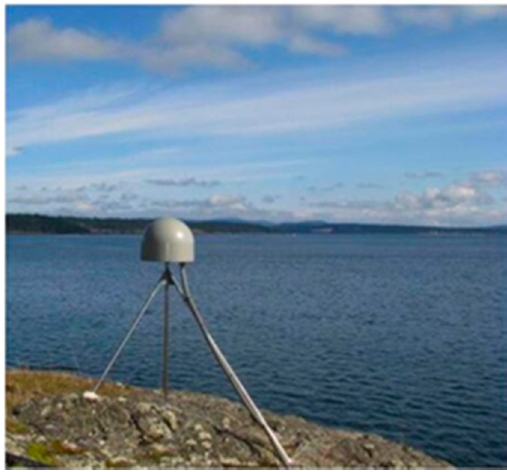
Figure 5. Photograph showing GPS station SC02 and the surrounding environment at Friday Harbor Port in Washington State, USA (image from http://www.sonel.org/spip.php?page=gps&idStation=2689).